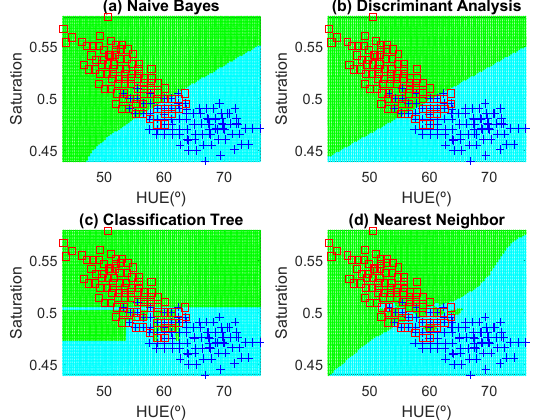
Figure 15. Decision boundaries and scatter plot (class 1 squares, class 2, crosses) for the golden apple. ( a ) Naive Bayes, ( b ) linear discriminant analysis, ( c ) classification tree and ( d ) Nearest Neighbor (k = 5).